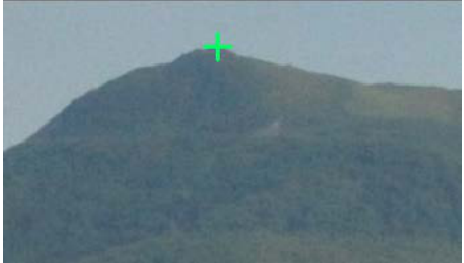
Figure 6. Measurement result of ImageB